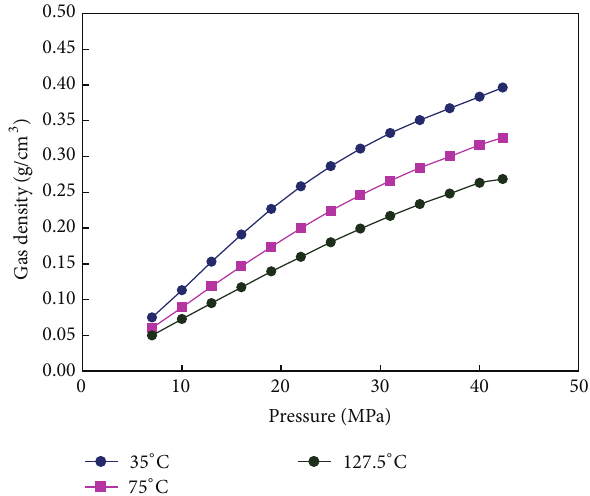
Figure 5: Variation of the relative volume of YP9 gas sample with pressure under different temperatures.